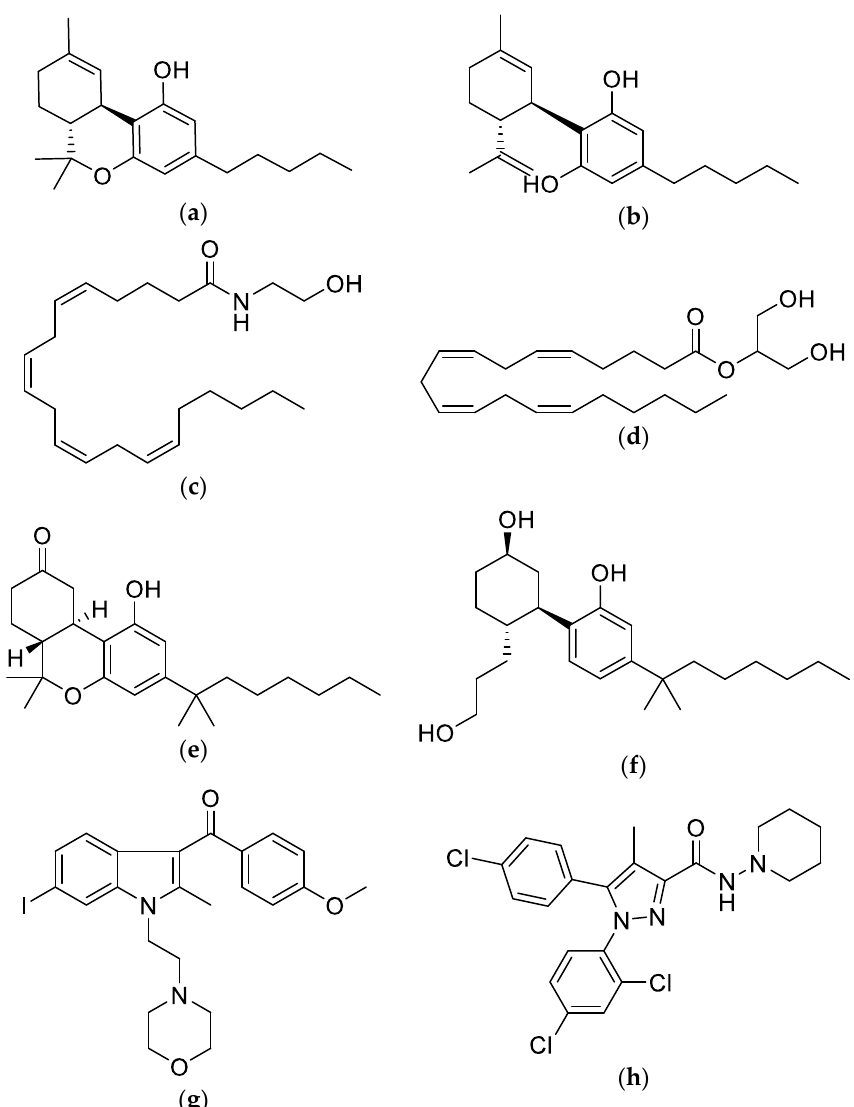
Figure 4. Chemical structures of the phytocannabinoids ( a ) Δ 9 -THC and ( b ) CBD, the endocannabinoids ( c ) Anandamide (AEA) and ( d ) 2-Arachidonoylglycerol (2-AG) and the synthetic cannabinoids ( e ) Nabilone, ( f ) CP 55,940, ( g ) AM-630 and ( h ) SR141716. Dronabinol is a synthetically produced form of Δ 9 -THC.